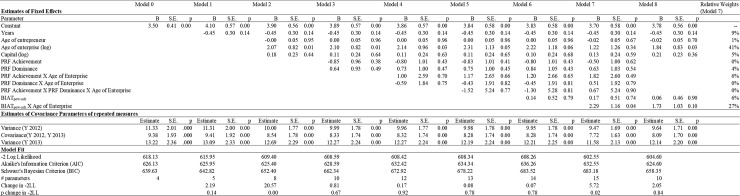
Johnson-Neyman plot of the region of significance for the effect of implicit power versus achievement on gross profit across the life span of an enterprise.